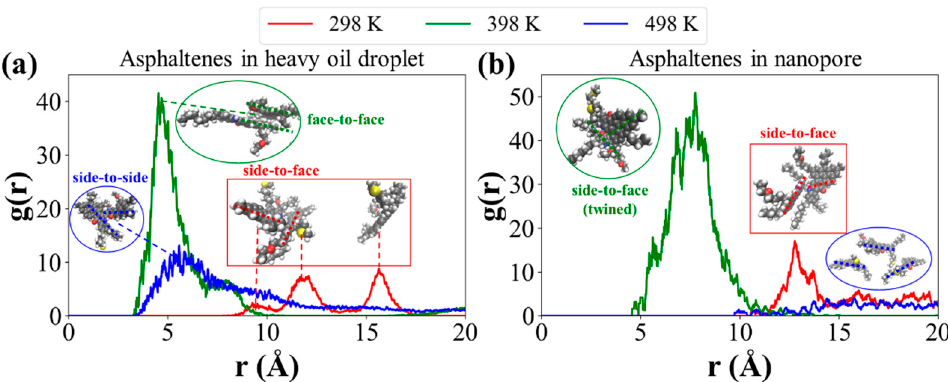
Figure 9. RDFs of resin molecule pairs in ( a ) heavy oil droplet and ( b ) nanopore at 298 K, 398 K, and 498 K, respectively, the snapshots of resin molecules in ( c ) heavy oil droplet and ( d ) nanopore at 298 K, 398 K, and 498 K, respectively.